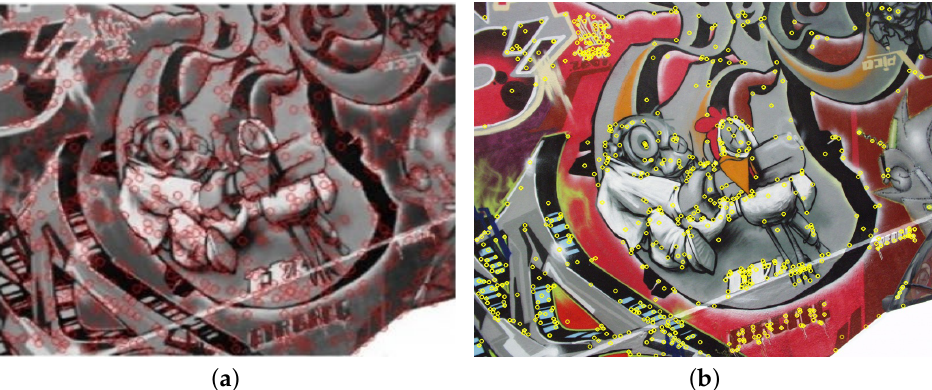
Figure 13. The extraction result of feature points of the image to be registered. ( a ) The adaptive RKEM algorithm; ( b ) The extraction result of the algorithm in this